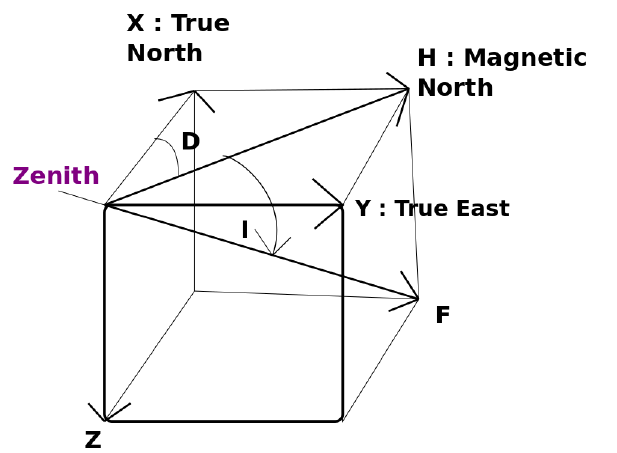
Figure 4. Different components of the magnetic field from NOAA. H is the magnetic north ( B x ) and Z the vertical component of the magnetic